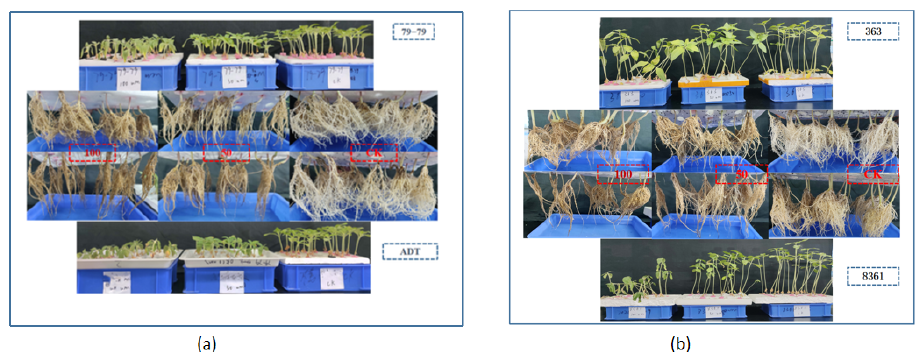
Figure 2. Morphological aspects of the four different sunflower varieties cultivated under Cd stress for six days. Plant culture was conducted using a hydroponic system. ( a ) 79 − 79 and ADT; ( b ) 363 and